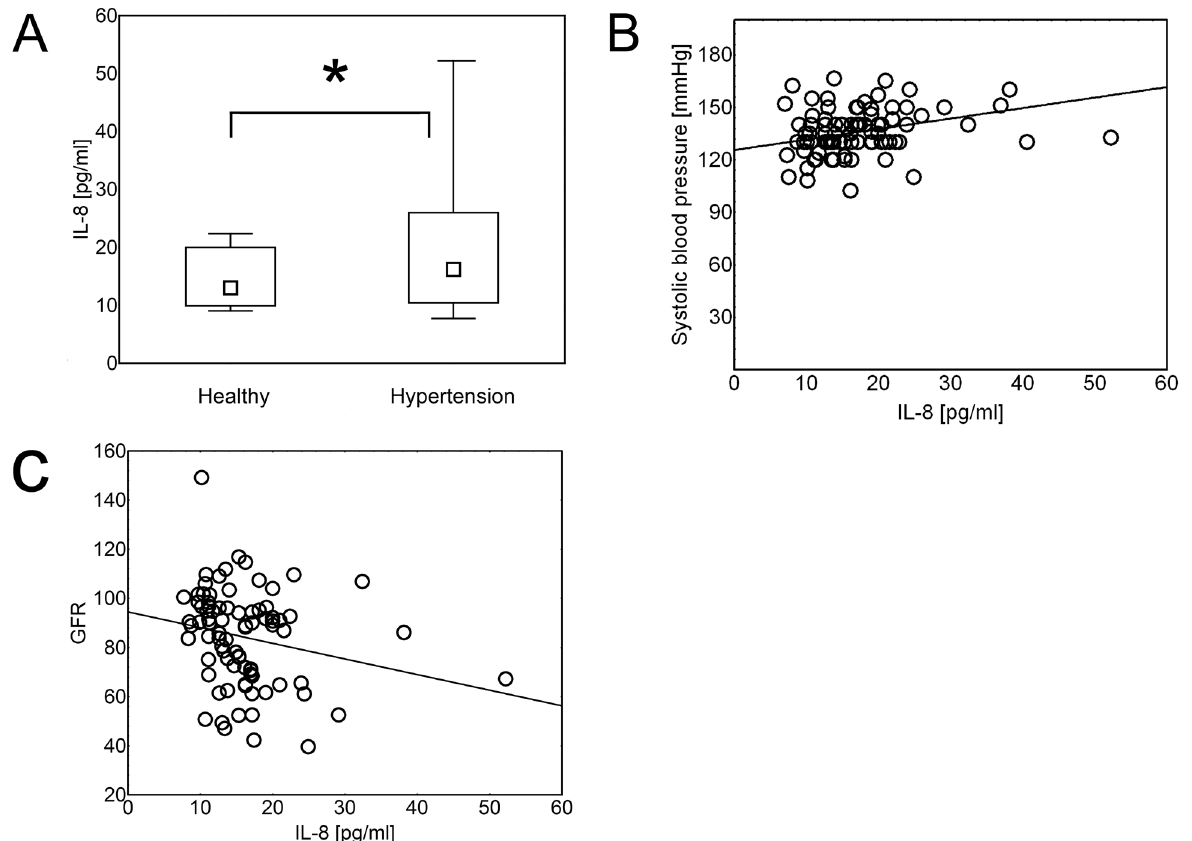
Fig 3. IL-8 concentration in hypertension. Hypertension was associated with increased serum levels of IL = 8 (Mann- Whitney U test; p = 0.02). The data are presented as medians (symbols inside the boxes), 25 – 75% percentiles (boundaries of the boxes) and minimum — maximum (error bars outside the boxes). Statistical significance (p < 0.05) is marked with “ * ” (A). Concentration of IL = 8 was in positive correlation (Spearman ’ s rank correlation) with systolic blood pressure (B; R = 0,326, p = 1x10 -3 ) and in negative correlation with glomerular filtration rate (GFR) (C; R = -0.26, p = 0.01). Correlations were calculated for both- hypertensive and healthy individuals